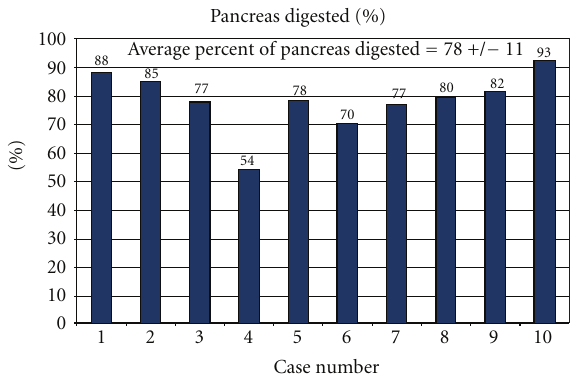
Figure 4: At the end of the isolation, some tissue is left in the digestion chamber. Of the undigested portion, only less than 20% was glandular, with a prevalence of fibrotic, calcified, and ductal tissue.